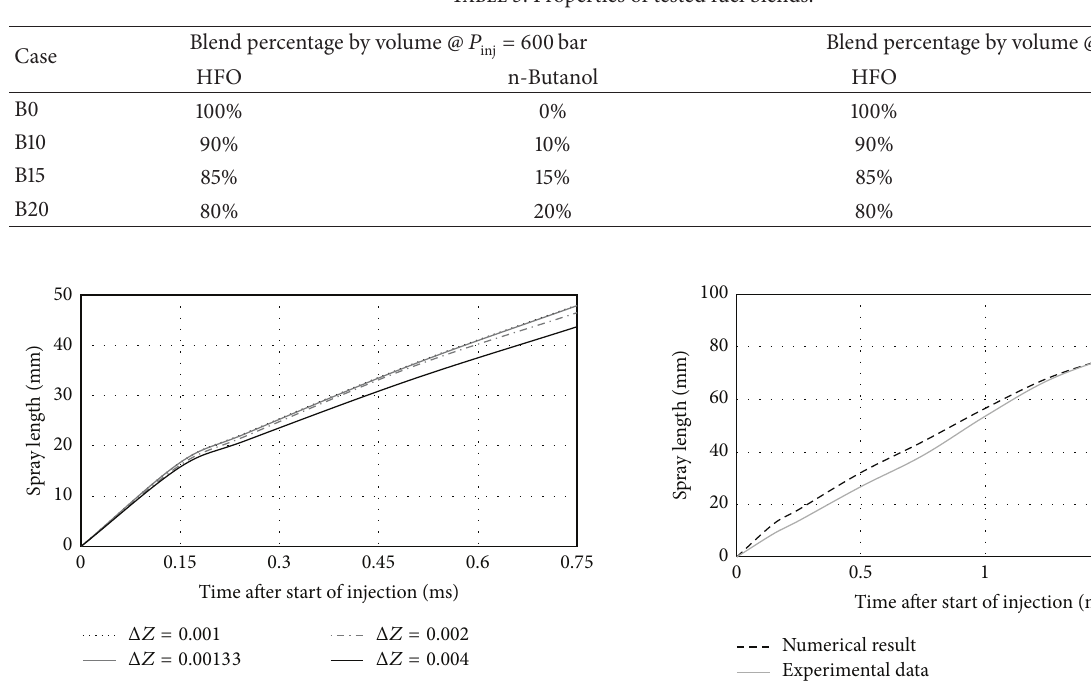
Figure 4: Mesh resolution sensitivity analyses of HFO spray length at injection pressure of 600 bar.